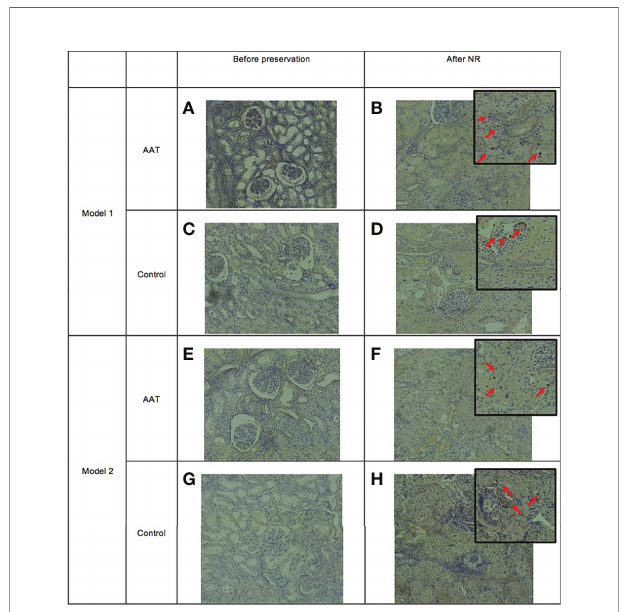
FIGURE 5 | In fi ltration of myeloperoxidase-positive (MPO+) cells into tissue following normothermic reperfusion (NR). Panels (A, C) represent alpha-1 antitrypsin (AAT) and control groups before static cold storage (SCS), and panels (B, D) represent tissue following NR in model 1 (7-h SCS + 3-h NR). Panels (E, G) are AAT and control groups before normothermic machine perfusion preservation (NMP), and panels (F, H) represent tissue following NR in model 2 (4-h SCS + 3-h NMP + 3-h